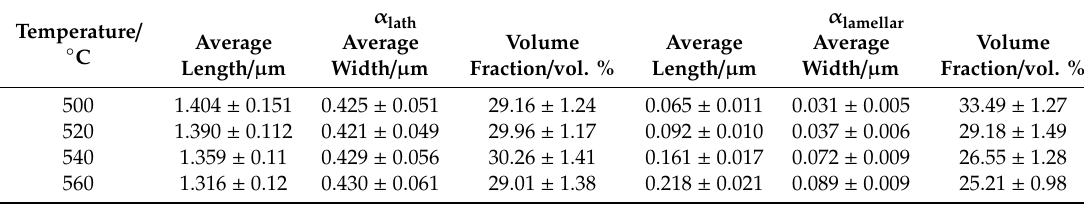
Table 3. Microstructure features of α phases after aging for 8